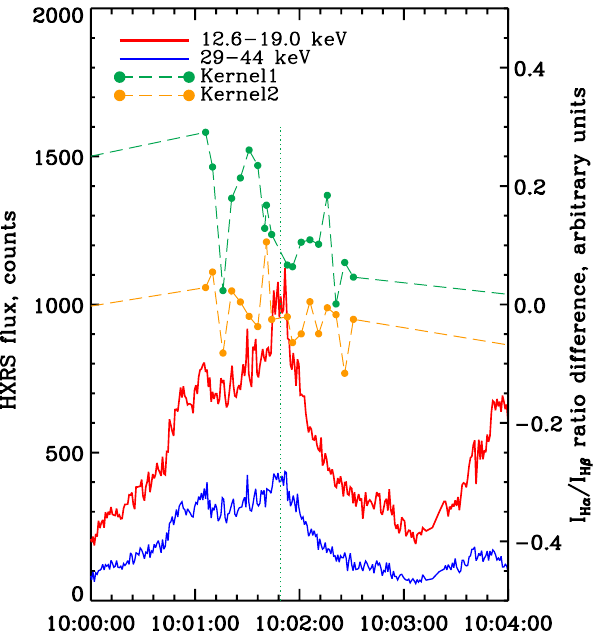
Fig. 10. Temporal evolution of HXR from HXRS and the difference between the H α /H β ratio values in the line center and at the distance 0.5 ˚A from the line center. The dash-dotted vertical green line shows the moment of missing MFS observations.